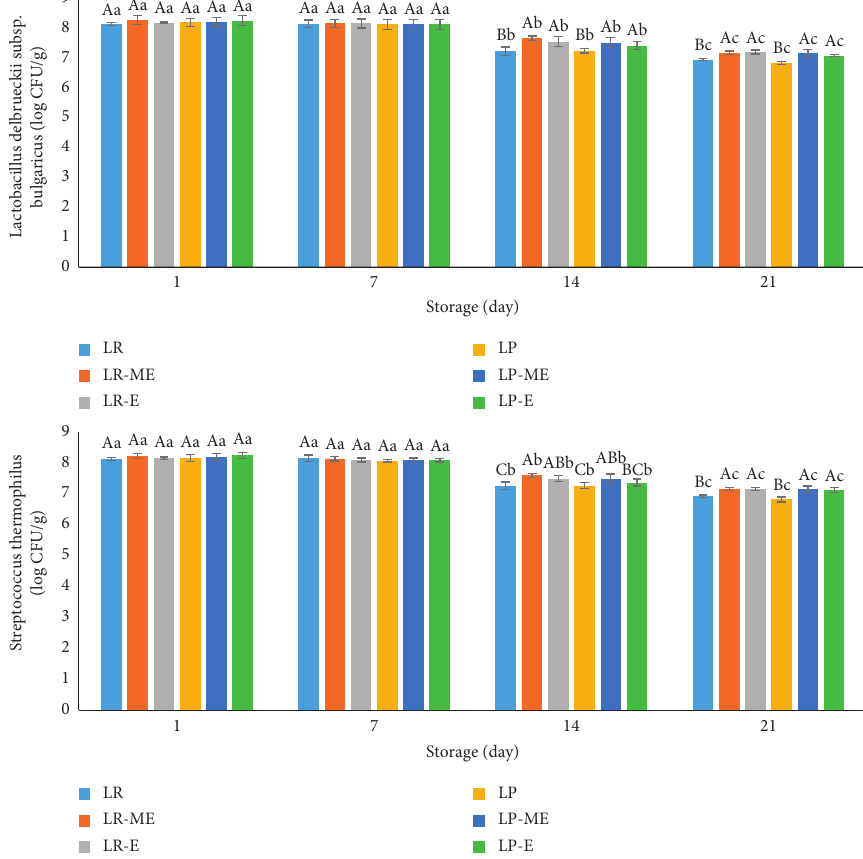
Figure 5: Starter count of probiotic yogurt. LR ( L. rhamnosus ), LR-ME (encapsulated L. rhamnosus in multilayer emulsion), LR-E (encapsulated L. rhamnosus in emulsion), LP ( L. plantarum ), LP-ME (encapsulated L. plantarum in multilayer emulsion), and LP-E (encapsulated L. plantarum in emulsion). Capital letters indicate significant differences between samples at the same storage time and different time; lowercase letters indicate significant differences between the same samples at different storage